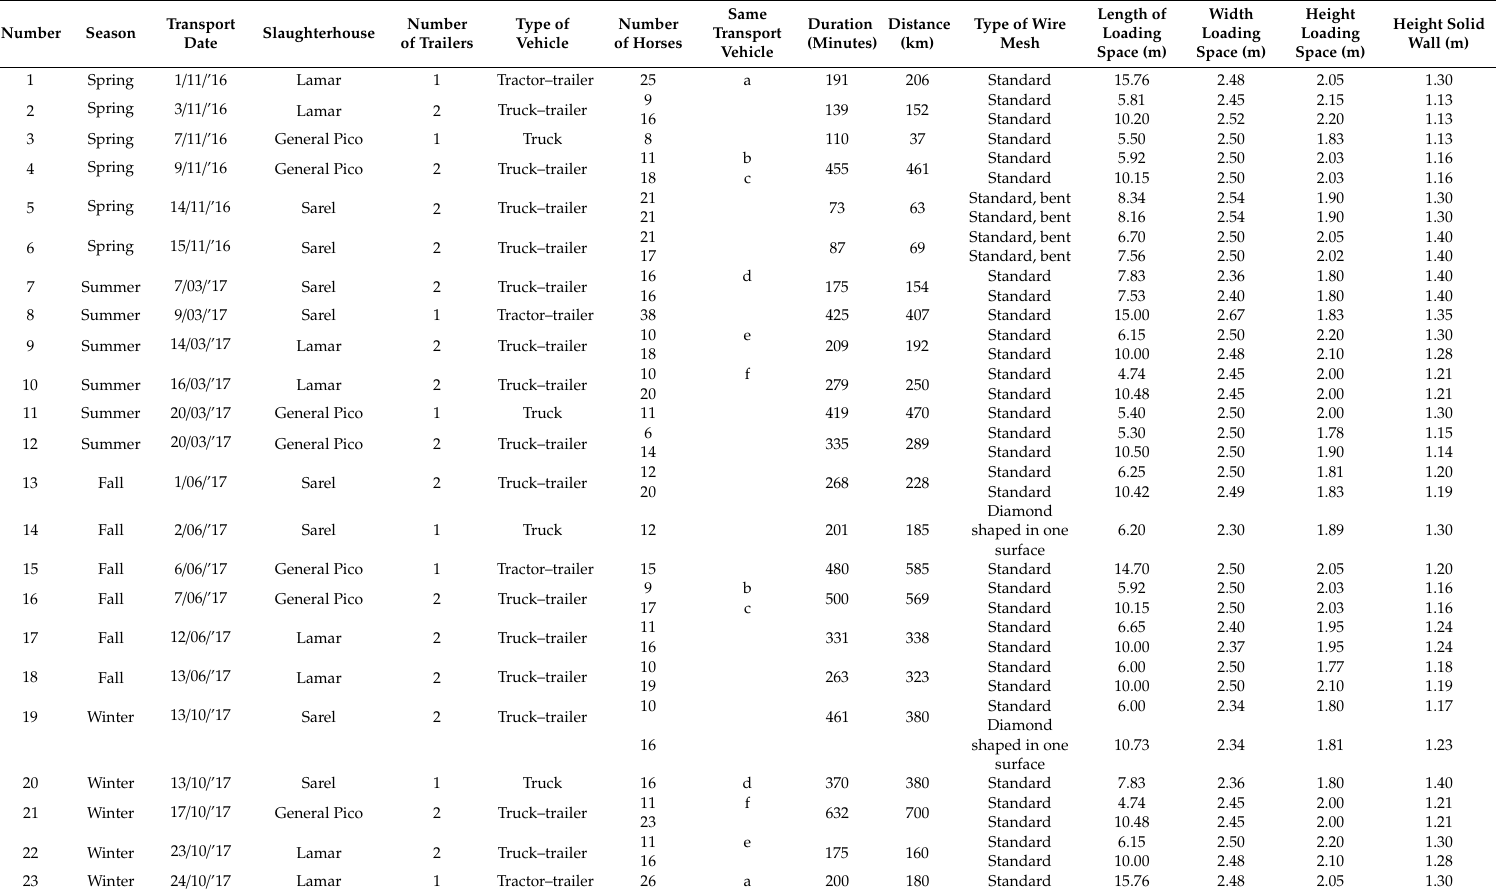
Table A3. Some details of the 23 observed transports. A letter in the column “Same transport vehicle” indicates that this (part of) the transport combination was also used in the other transport where the same letter is mentioned. In the column “Number of trailers” is mentioned of how many the loading spaces the transport combination consists. The internal dimensions of the loading spaces and the height of the solid wall are given in the last four columns. “Solid wall” refers to the part of the side wall of the loading space which is not made up of trellis. The function of the solid wall is to block the view of the horses and more importantly to prevent the horses from getting stuck (with their legs) in the